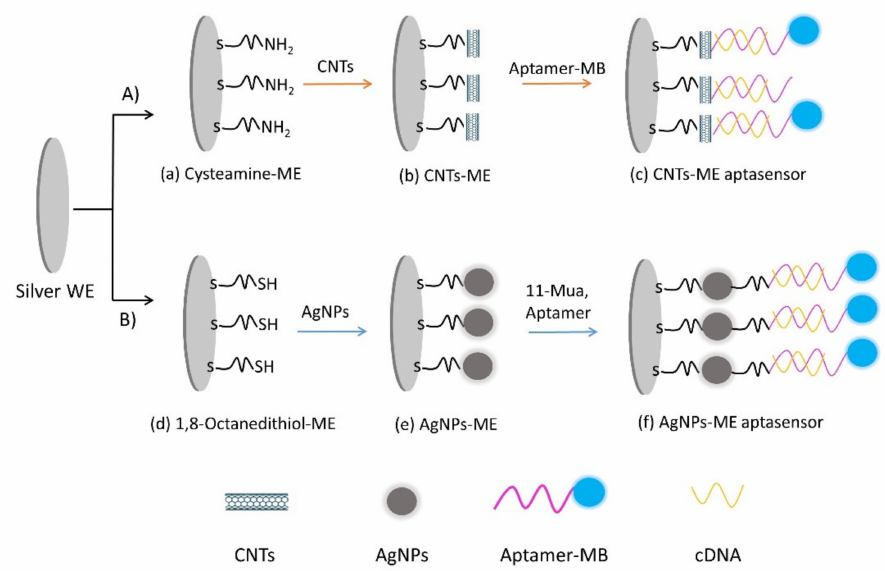
Figure 1. Fabrication process flow of CNT-ME ( A ) and AgNP-ME ( B ) aptasensors: (A) first bare electrode was modified with cysteamine ( a ), and CNTs were immobilized on top of the cysteamine-ME to form CNT-ME ( b ); afterward, aptamer-MB was immobilized onto the CNT-ME ( c ). (B) first bare electrode was modified with 1,8-octanedithiol ( d ); afterward, AgNPs were immobilized on top of bare-1,8-octanedithiol to form AgNP-ME ( e ). The AgNP-ME was modified with 11-MUA, and